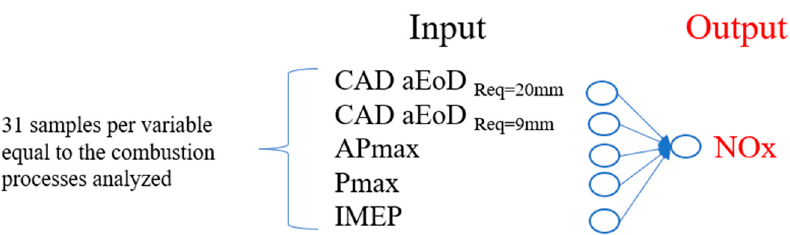
Figure 11. Description of the input parameters used to quantify their influence on the NOx prediction using the Shapley value.